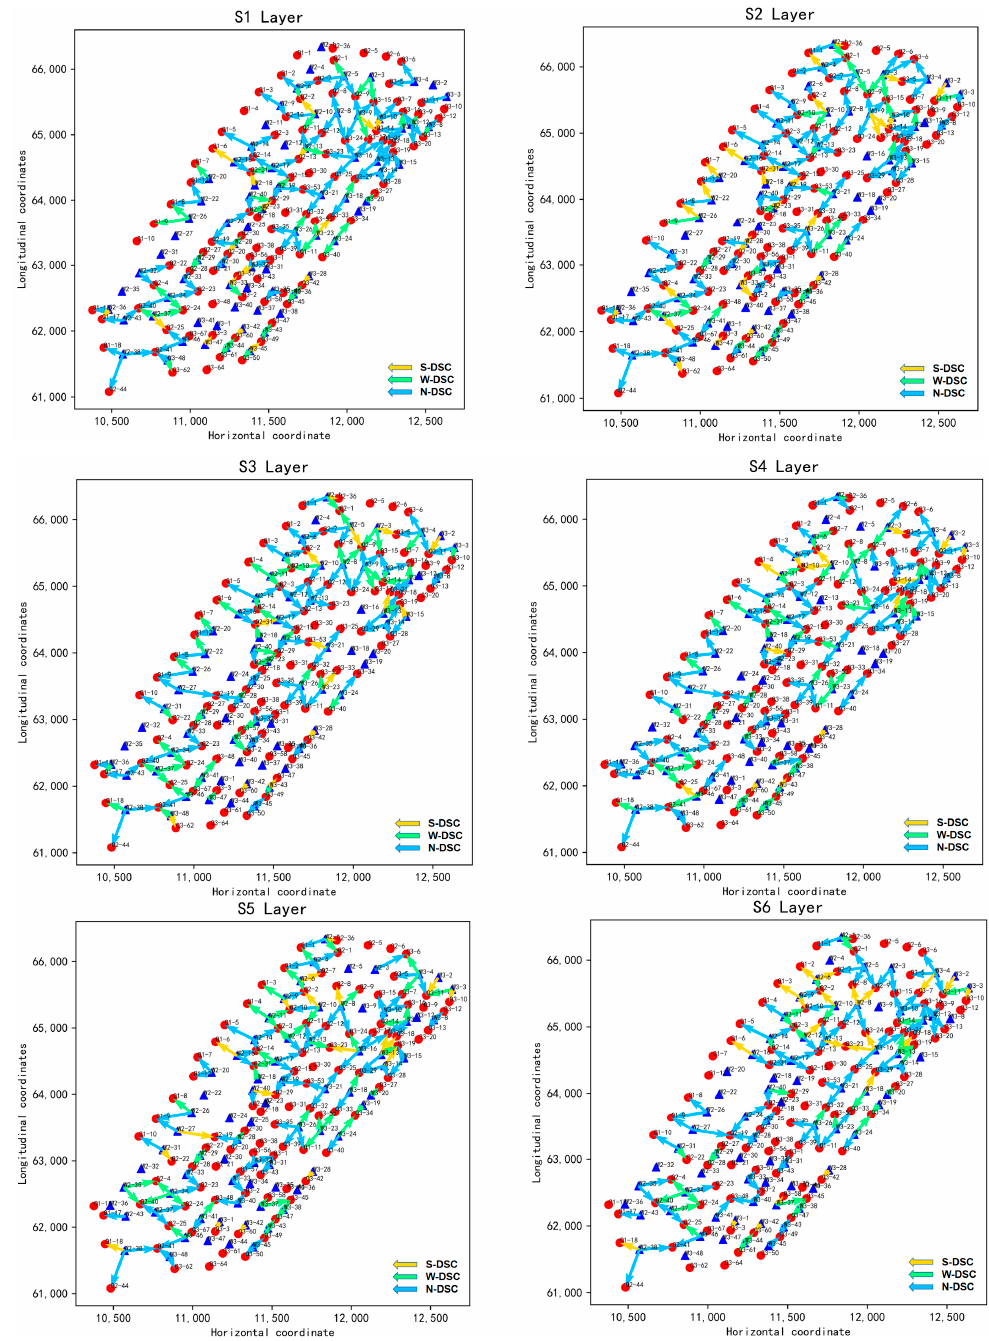
Figure 13. Identification results of advantage seepage